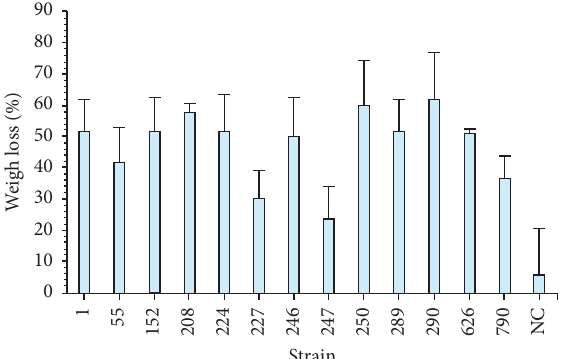
Figure 2: PVC biodegradation as a weight loss percentage by the selected strain on MSM. NC is the negative control (i.e., MSM+PVC resin with no bacterial exposure). Te negative control was subjected to the same culture conditions as the experimental treatments. All values are presented as mean ± error of data based on experiments performed in triplicate. Bars indicate the standard deviation of data.